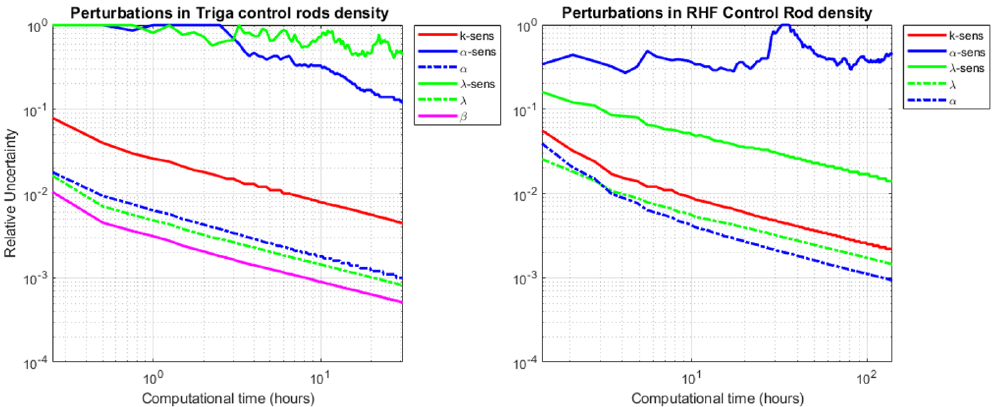
Figure 6: Comparison of convergence behavior for the TRIGA and the RHF control